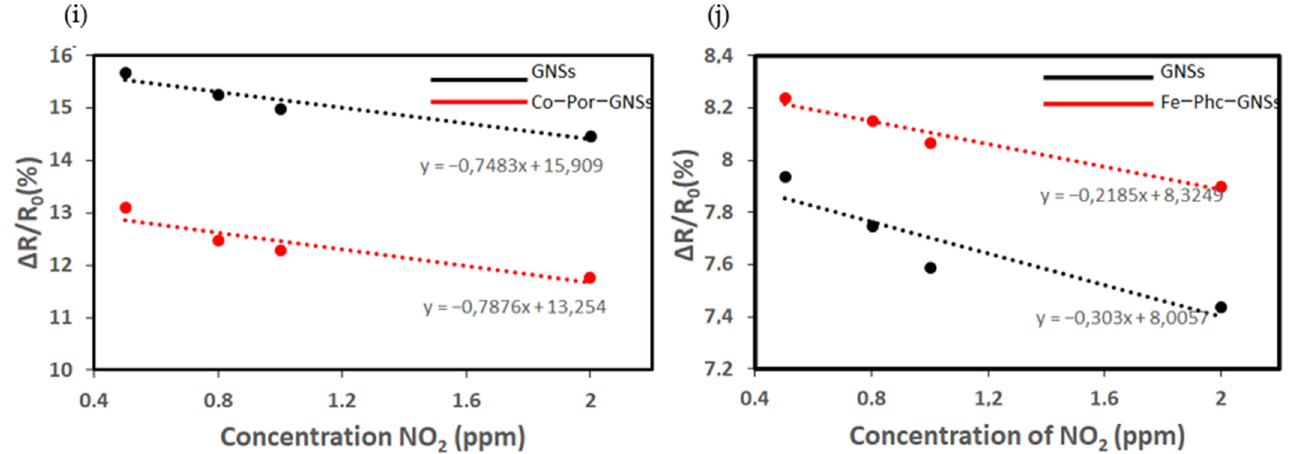
Figure 8. ( a – j )The response of pristine GNS sensor and functionalized GNS sensors to NO 2 gas under various concentrations ranging from 0.5 ppm to 2 ppm. Table 1. Responsivity and recovery time of pristine GNS and functionalized GNS gas sensors ex- posed to 0.5 ppm of NO 2 at room temperature.